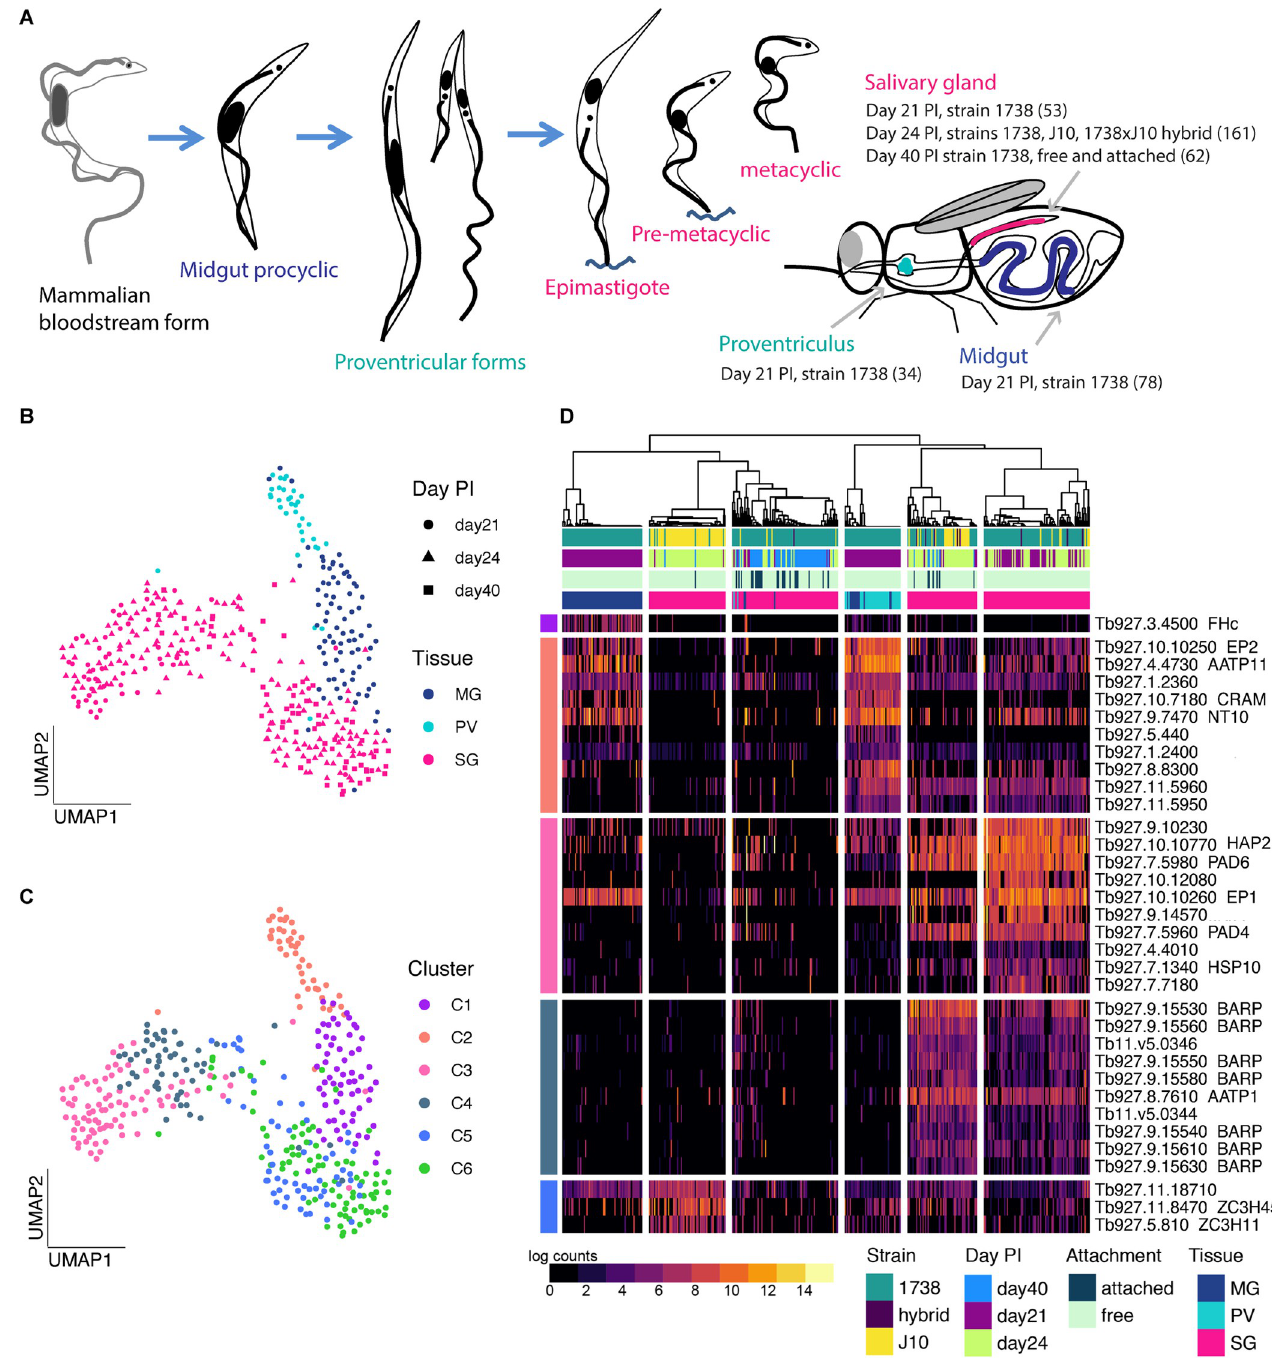
Fig 1. scRNAseq analysis of trypanosome developmental stages in tsetse. (A) A schematic of the trypanosome life cycle and collections of the single parasite transcriptomes from midgut (MG; blue), proventriculus (PV; turquoise) and salivary glands (SG; pink) from different time points and strains. The number of parasites that passed QC at each collection is shown in parentheses. Trypanosomes show two conformations: trypomastigote with kinetoplast (small black dot) posterior to nucleus ( e . g . bloodstream form, procyclic, metacyclic) and with kinetoplast anterior to nucleus ( e . g . epimastigote). (B) A UMAP of the 388 cells that passed QC across collections, coloured by tissue of origin. (C) The UMAP coloured by cluster assignment. (D) A heatmap of the top significant marker genes from each of the five clusters that had marker genes (AUROC > 0.75 & adjusted p -value < 0.01).